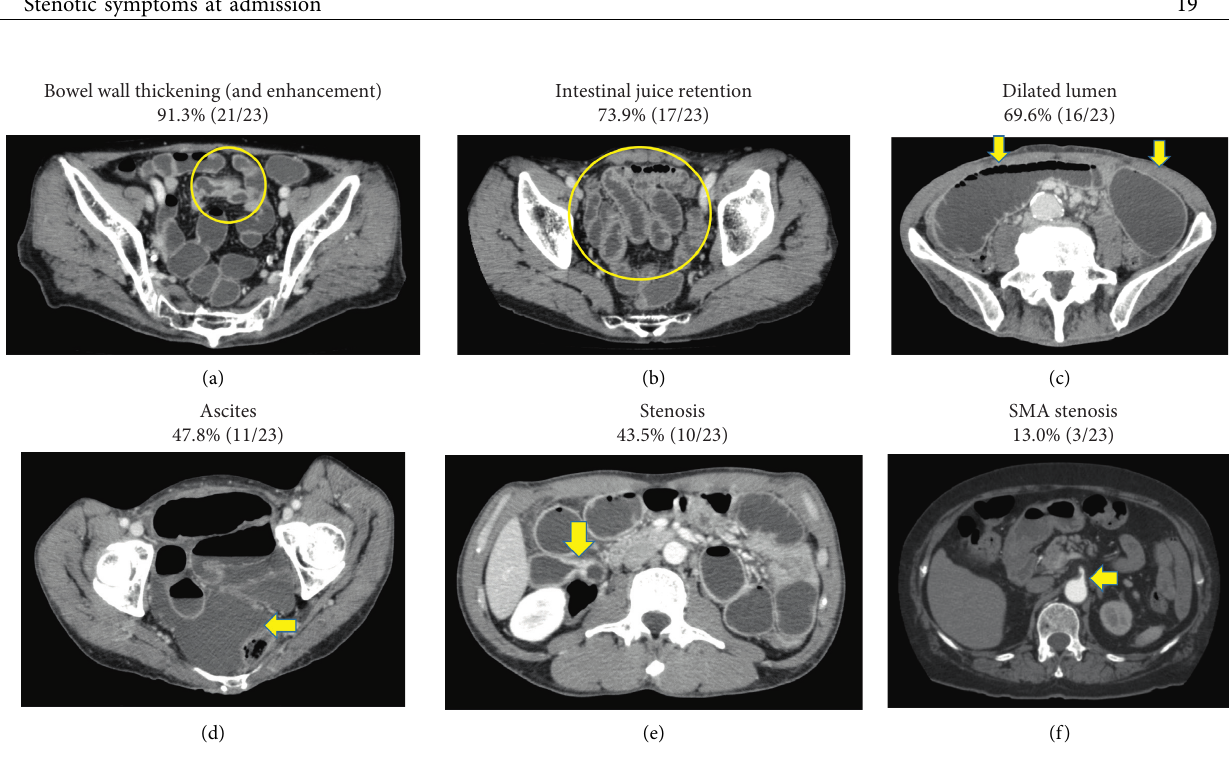
Figure 1: Positive computed tomography findings in patients with ischemic